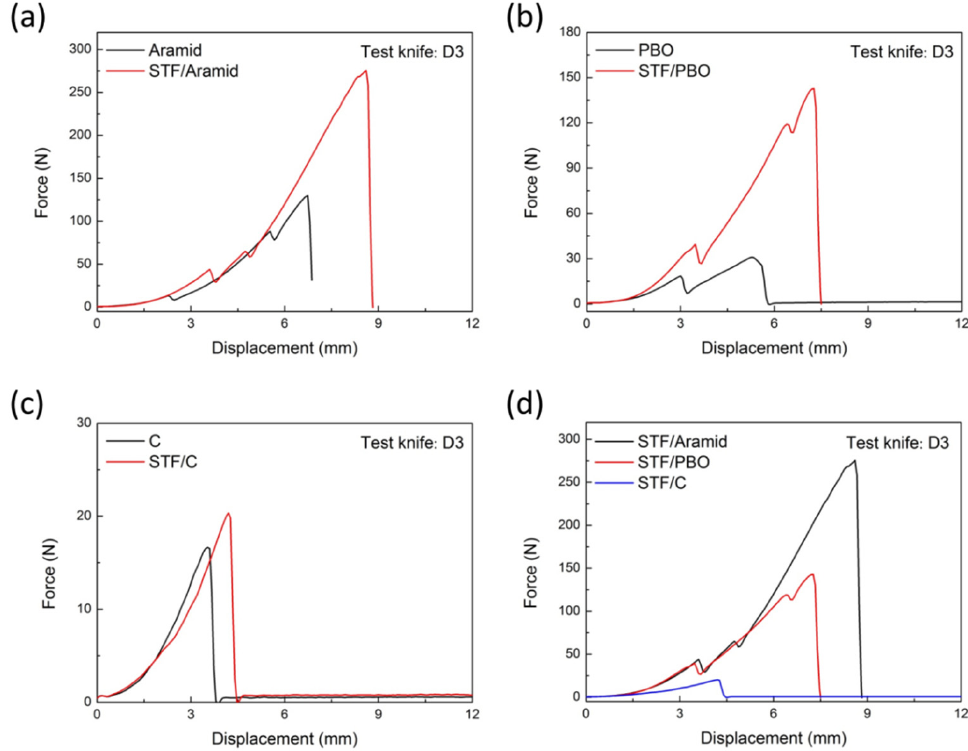
Figure 4. Force–displacement curves of neat and STF-treated fabrics penetrated with the D3 tool. ( a ) Aramid-based fabrics; ( b ) PBO-based fabrics; ( c ) C-based fabrics; ( d ) STF-treated fabrics summary. Table 2. Peak piercing force of different fabrics when punctured by D3 knife. Samples